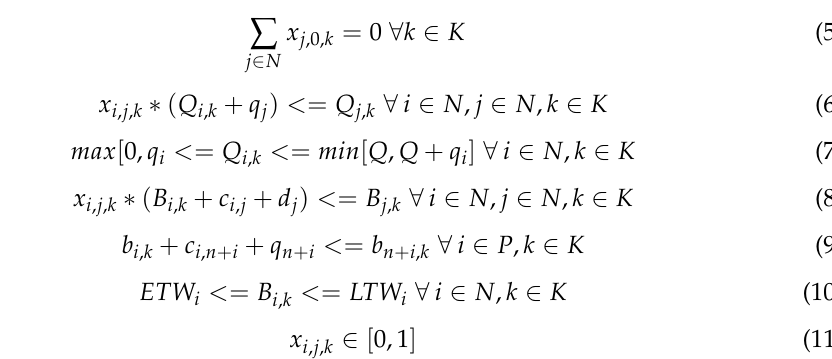
Figure 1. Example route with 5 pickups and 5 deliveries; n = Figure 1. Example Route with 5 pickups and 5 deliveries, n = 5